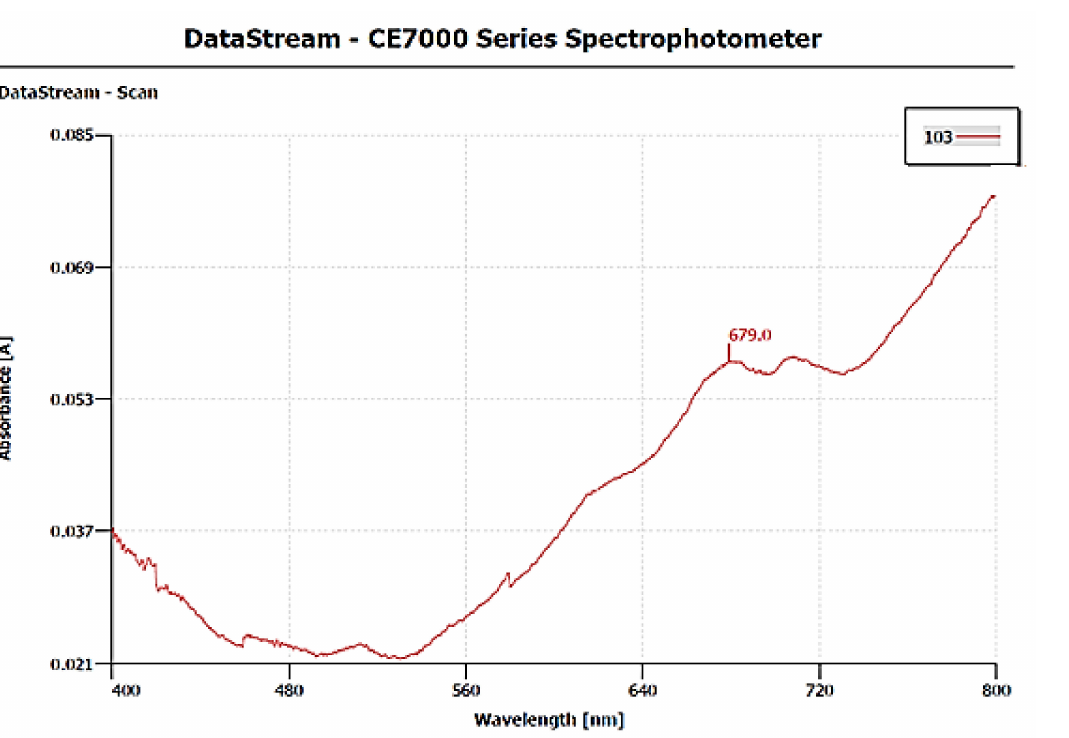
Figure 4. UV-Vis spectrum shows absorption peak of synthesized